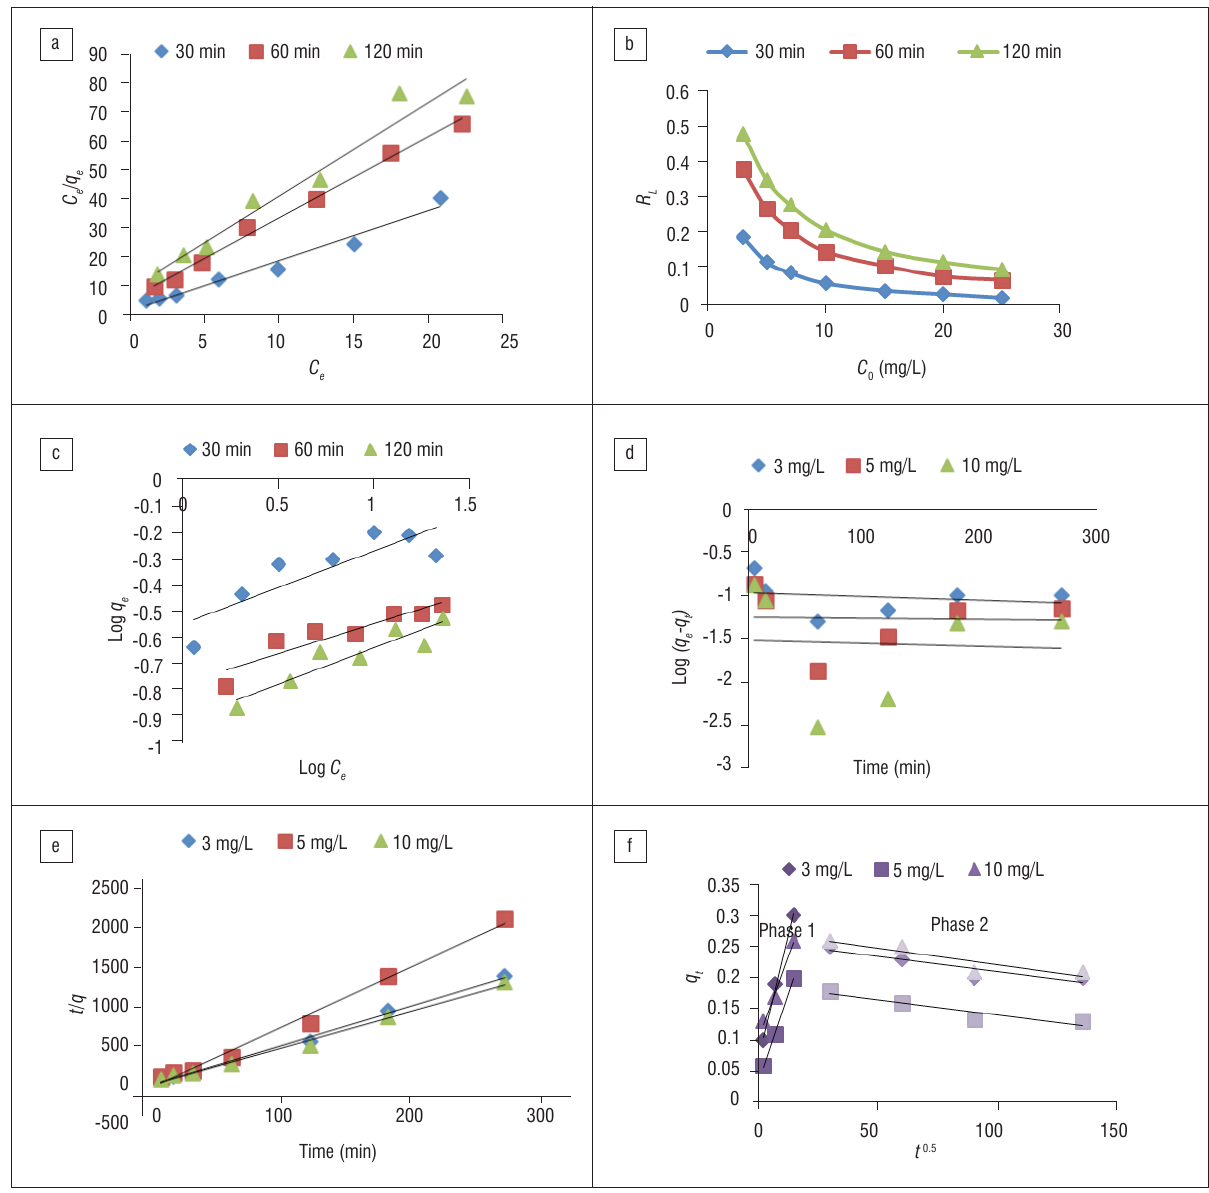
Figure 7: (a) Langmuir isotherm, (b) equilibrium dimensionless parameter, (c) Freundlich isotherm, (d) pseudo first order, (e) pseudo second order and (f) intra-particle diffusion of the adsorption of fluoride by smectite-rich clay soil. Table 3: Constant values for adsorption isotherms and adsorption kinetics model Langmuir isotherm Freundlich isotherm